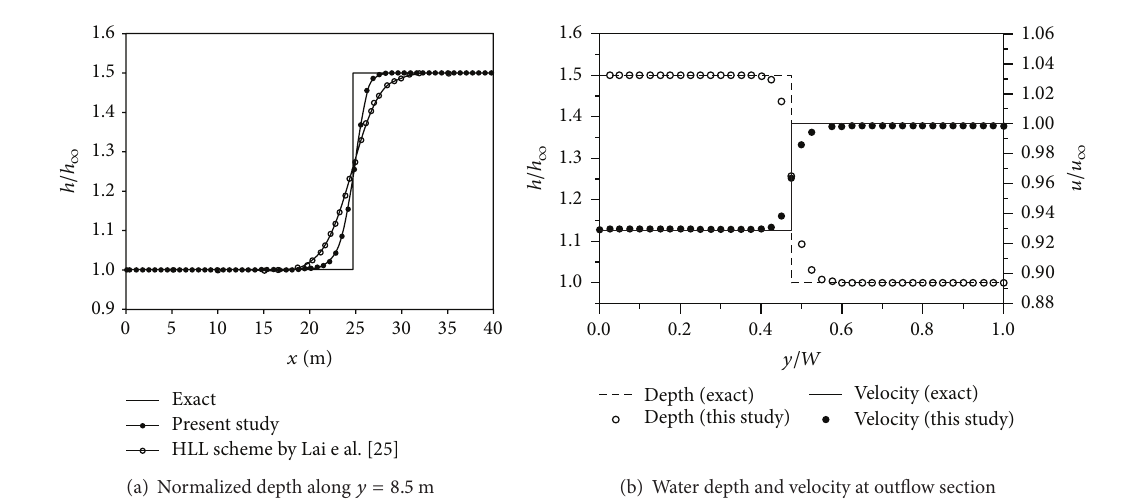
Figure 14: Comparison of water depth and velocity for oblique hydraulic jump